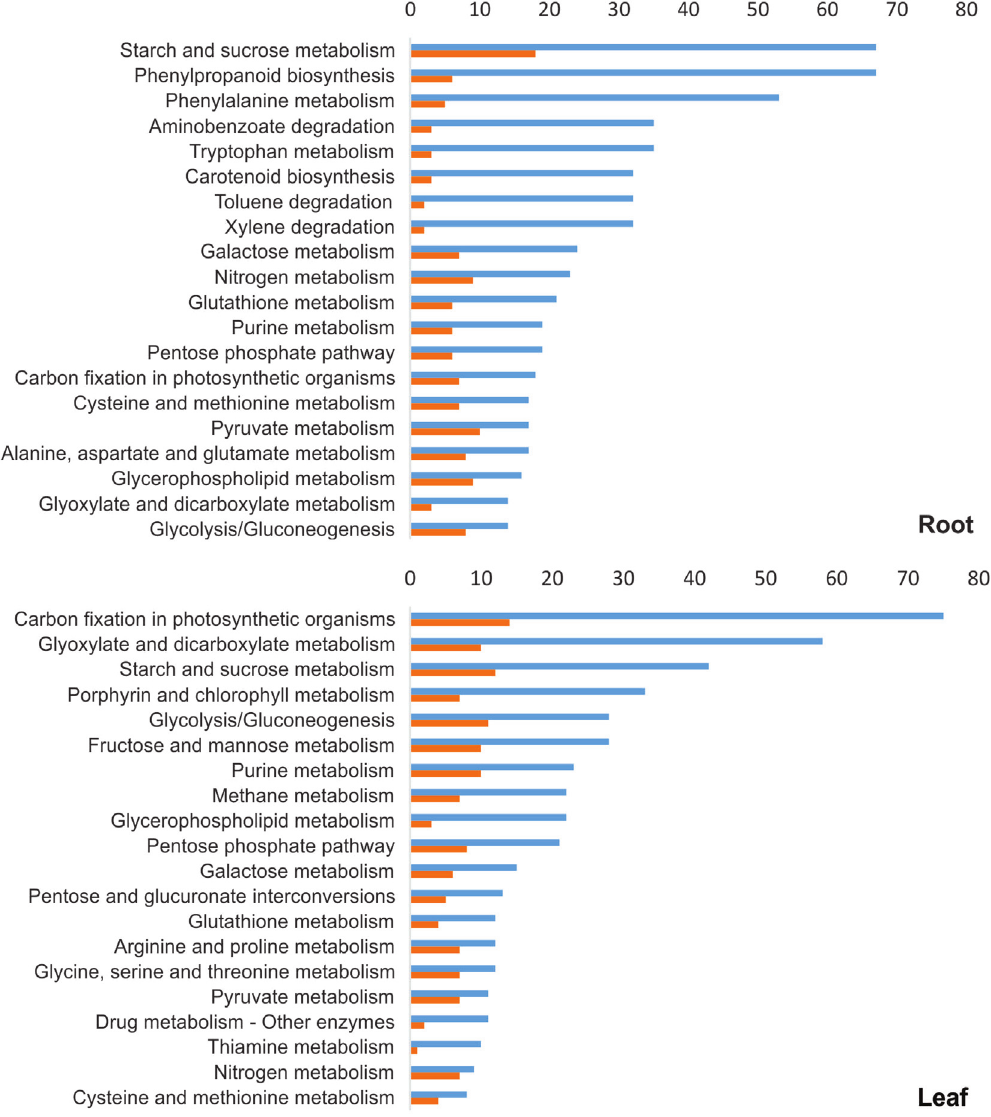
Figure 6 - Top 20 biological pathways of root and leaf tissues activated in the wheat cultivar MGS1 Aliança under drought conditions. Sequences were analyzed by Blast2GO against the Kyoto Encyclopedia of Genes and Genomes (KEGG). Blue bars represent the number of sequences and orange bars represent the number of